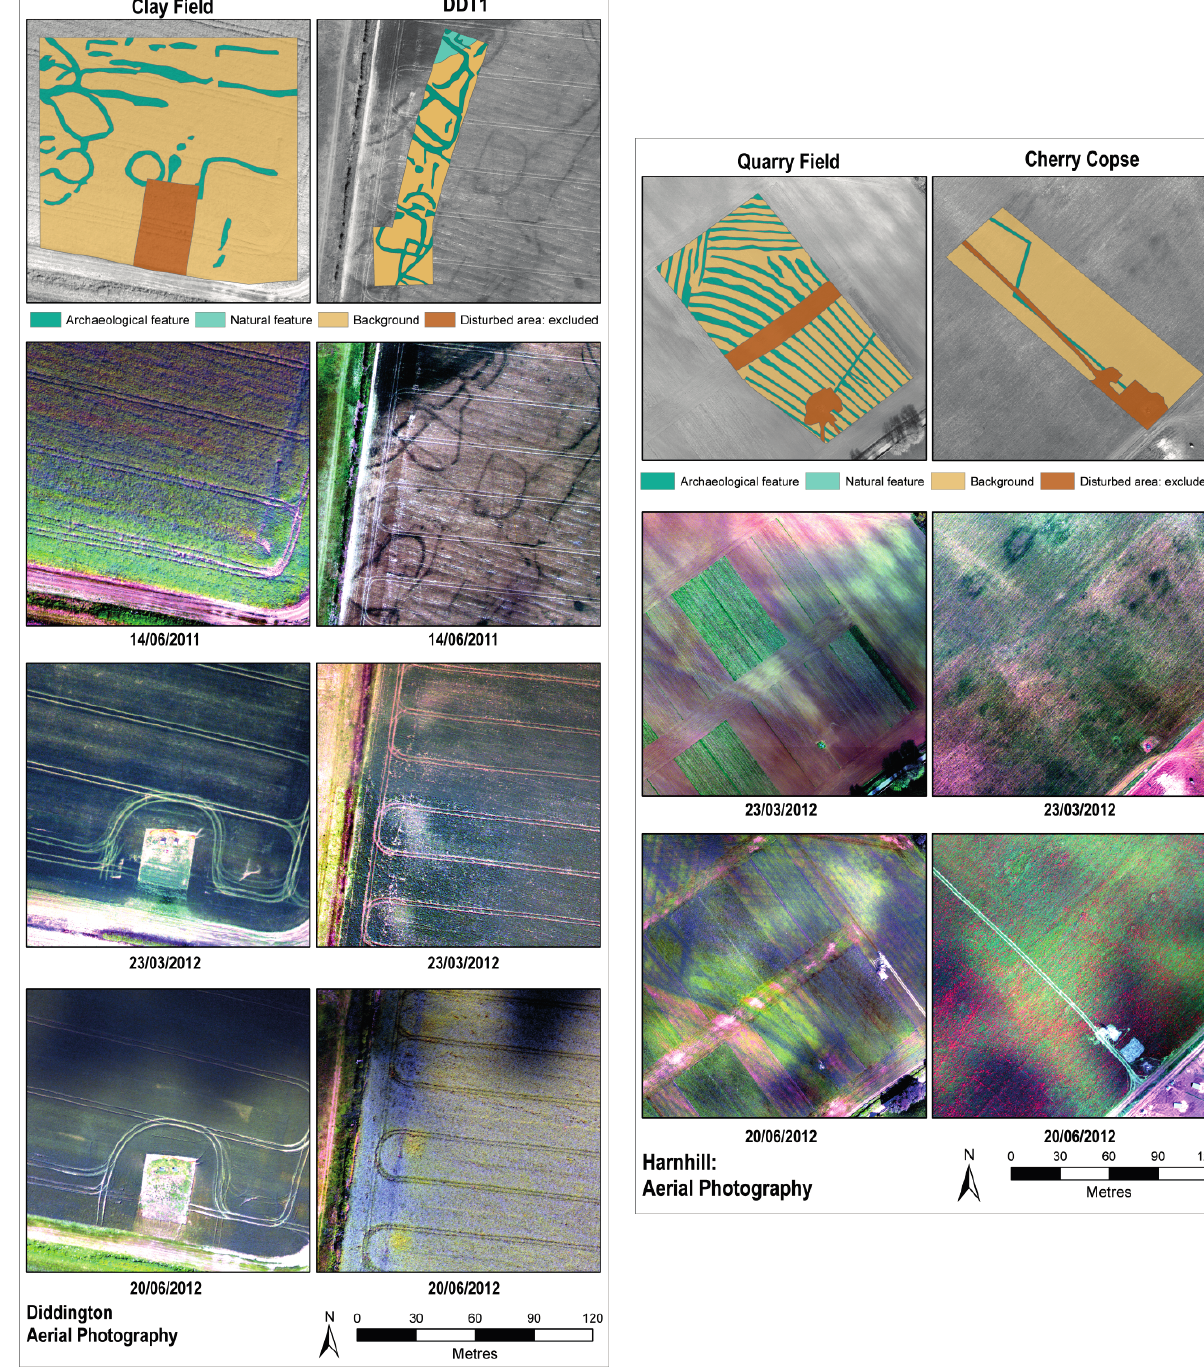
Figure 2. Magnetometer survey results for each of the four fields under investigation (top box in each column) and the corresponding aerial photography taken for each date that NERC ARSF surveyed each site. Note (i) that an ARSF survey was not undertaken in June 2011 for the Harnhill site and (ii) areas that have been disturbed at the Clay field at Diddington and both fields at